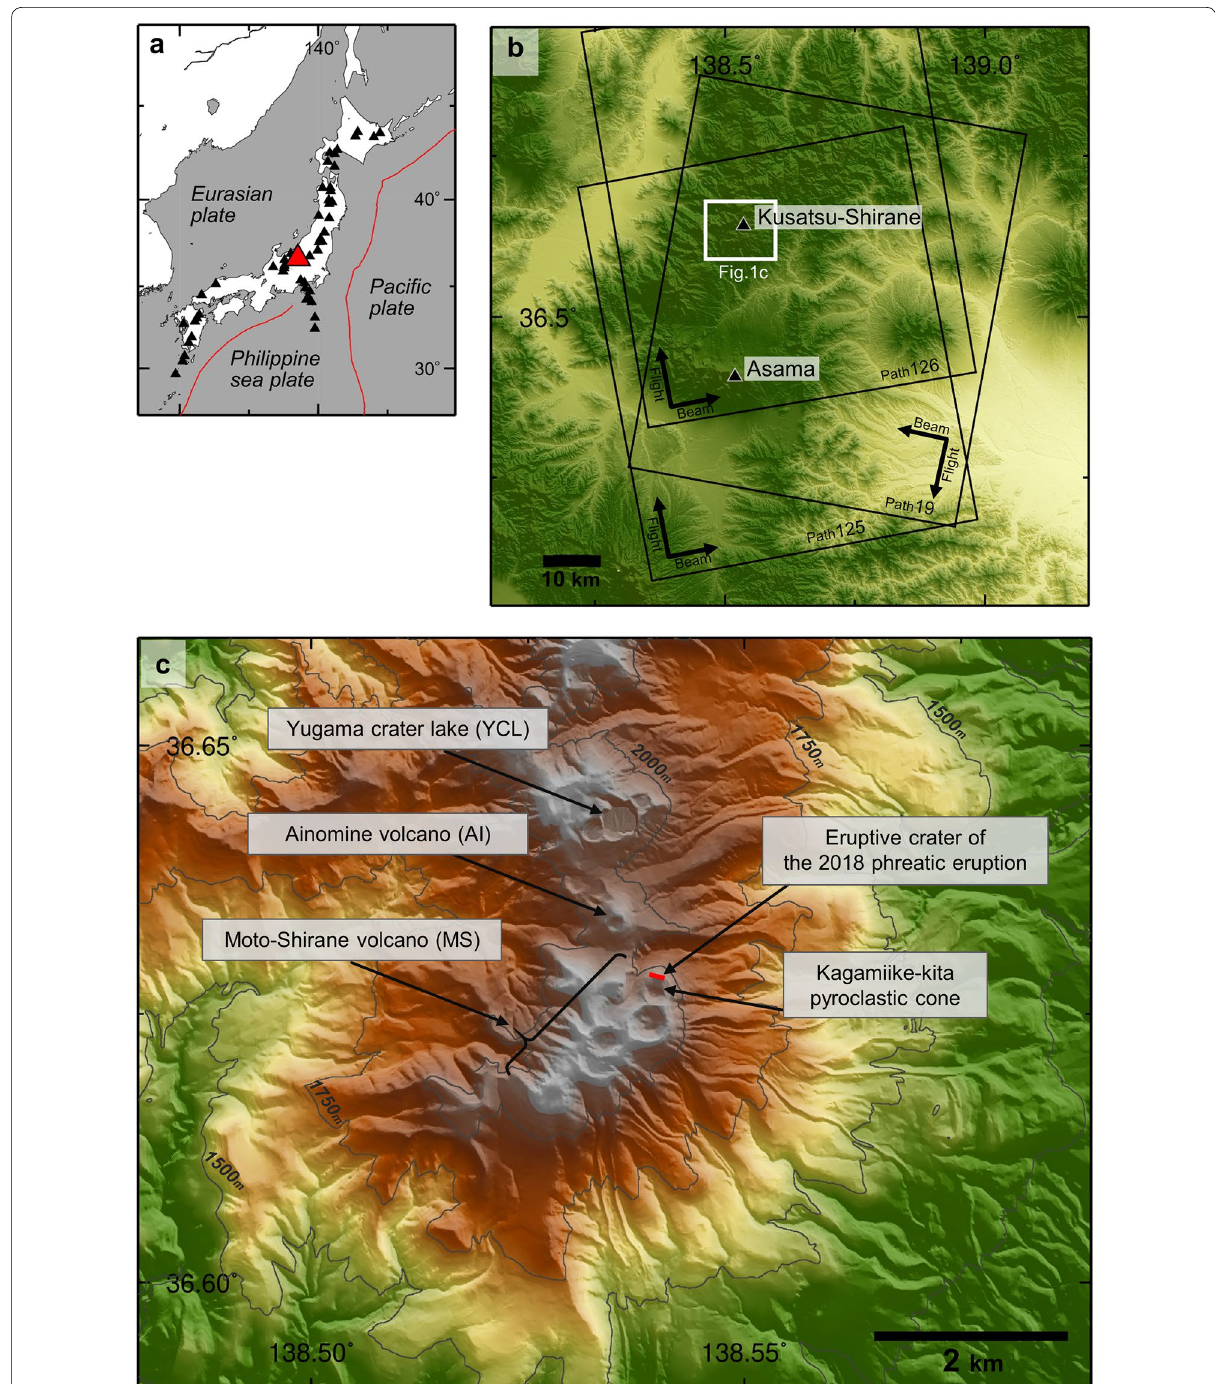
Fig. 1 Map of the study area. a Location of Kusatsu-Shirane volcano (red triangle). Black triangles indicate locations of active volcanoes in Japan. Red lines trace boundaries between tectonic plates. b Location of Kusatsu-Shirane volcano with ALOS-2/PALSAR-2 footprints (black boxes) used in this study. Black arrows indicate satellite flight directions (Flight) and line-of-sight directions (Beam). c Enlarged map of Kusatsu-Shirane